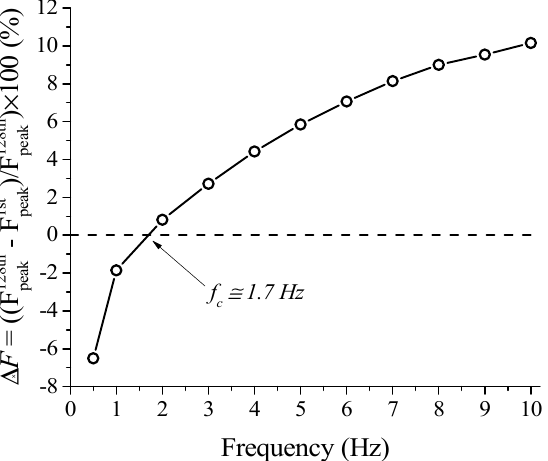
Figure 9. Determination of the critical frequency of self-heating for the SMA Belleville spring.